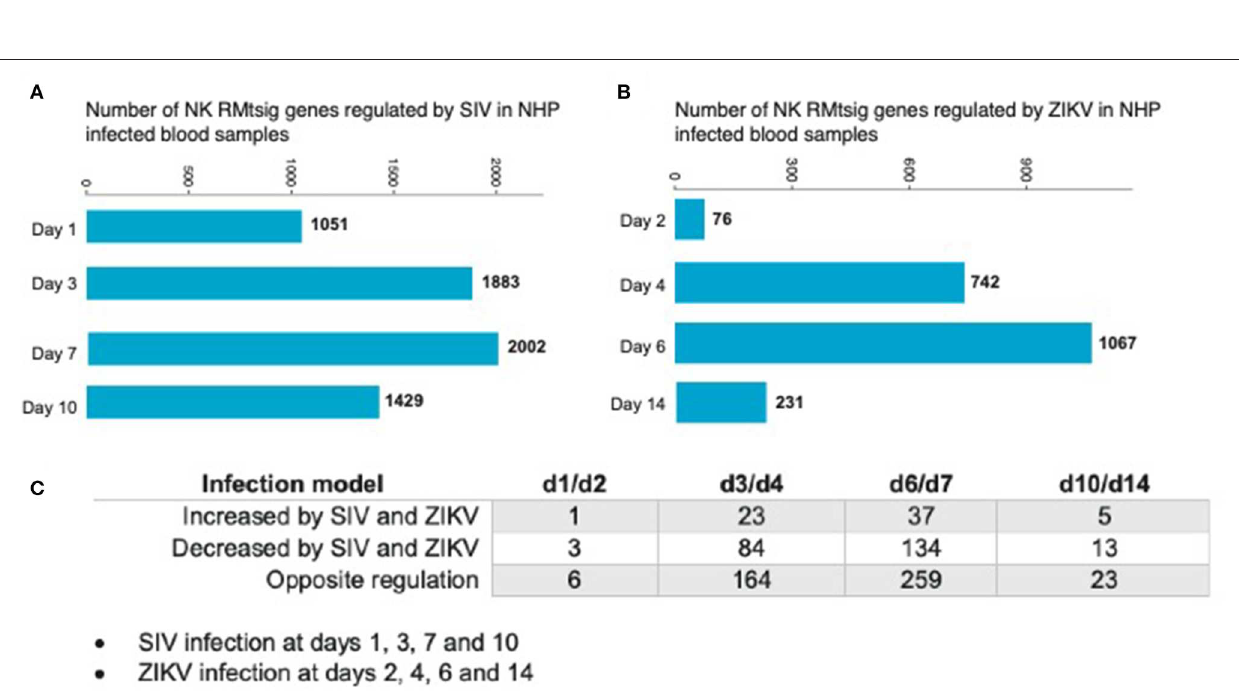
FIGURE 6 | Transcription factors regulating epigenetic modifications, proliferation, cell homeostasis, T follicular helper cell and B cell functions are enriched in the NK RMtsig. (A) Scatter plot showing the 332 human transcription factors (TFs) enriched in NK RMtsig. All TFs were ranked using their expression from high to low. X axis represents gene rank and Y axis represents the Log 2 transformation of average cpm count for each TF. Red color gradient and circle size represent TF expression level. Highly ranked TFs were shown in darker red and bigger circles. (B) Genes networks representing transcription factors (TFs) targets, selected from panel A, enriched in the NK RMtsig. TF names are shown in the middle with square red nodes, where each TF (red node) is connected to its targets (gray nodes) with red arrows.